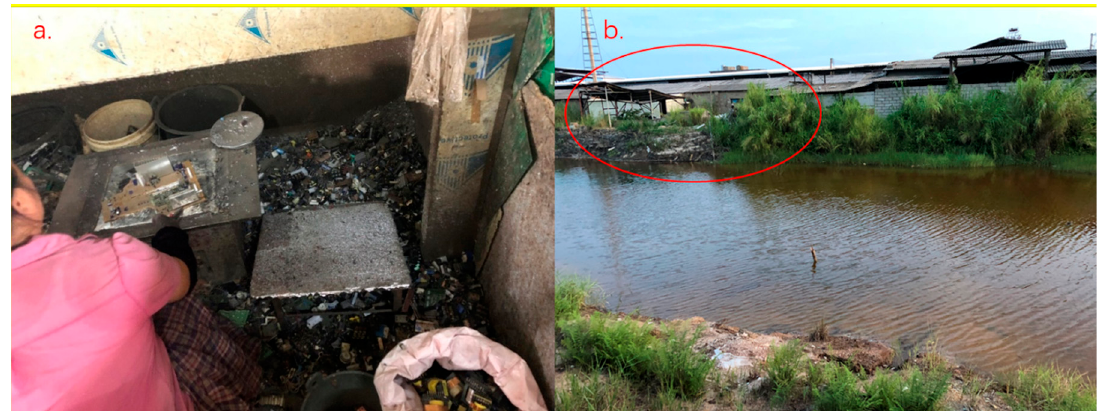
Figure 2. Workshops of circuit board baking and precious metal extraction in Guiyu. Source: author’s copyright